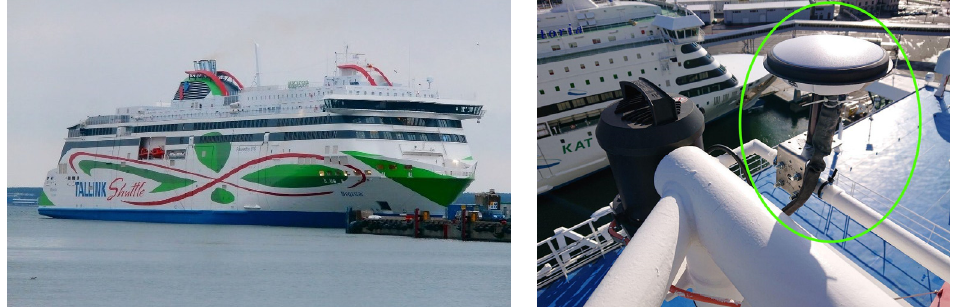
Figure 2. MS Megastar [23] cruise ship ( left ), GNSS antenna installed on the top mast of the vessel marked within green ellipsoid ( right ).